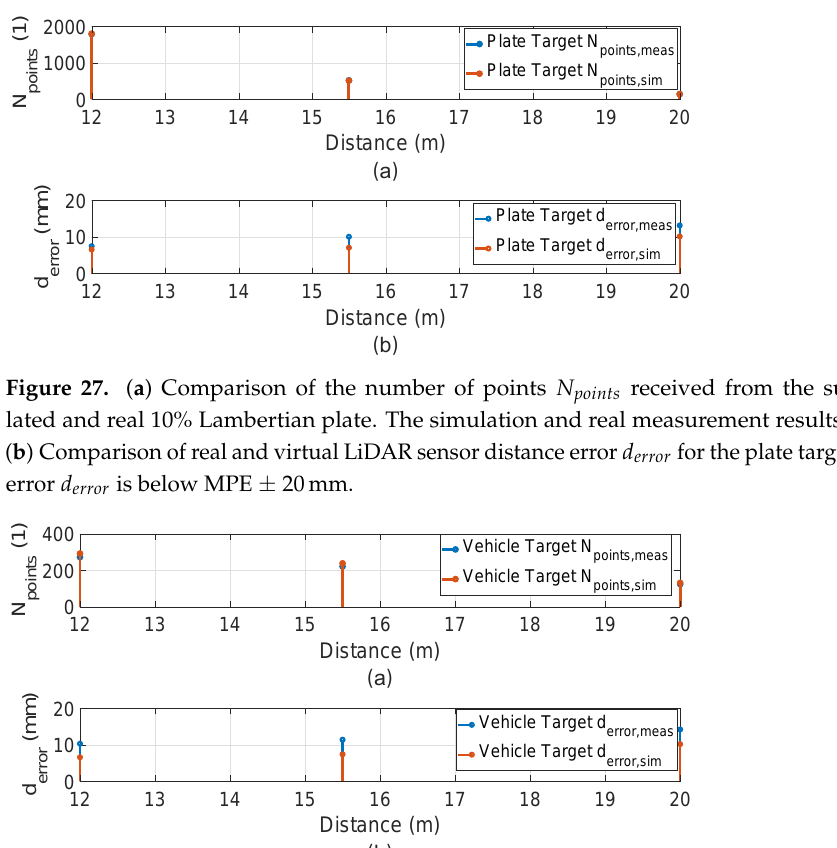
Figure 26. Visualization of LiDAR point clouds obtained from the real and simulated vehicle placed at 12m. The actual width and height of the vehicle is 1.76 × 1.25m, the LiDAR FMU and Cube 1 estimate 1.74 × 1.23m and 1.74 × 1.22m, respectively. The vehicle’s height is calculated from the bottom of the rear bumper to the vehicle’s roof. The red dots in the picture show the difference between the simulated and real point clouds.